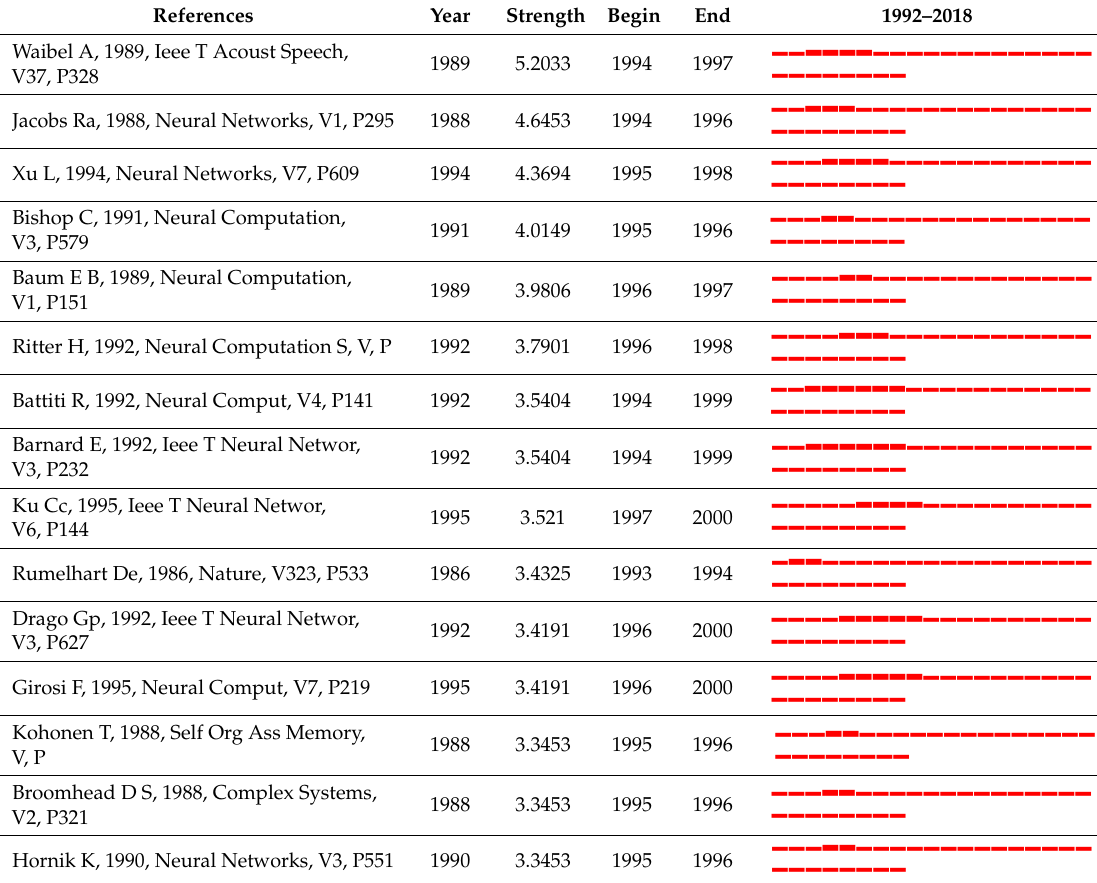
Table 8. Top 30 References with the Strongest Citation Bursts. References